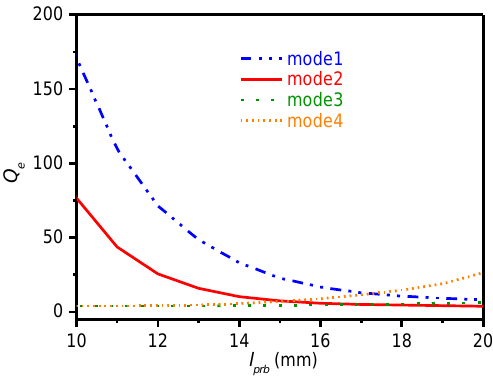
Figure 6. External quality factor Q e against varying l prb.